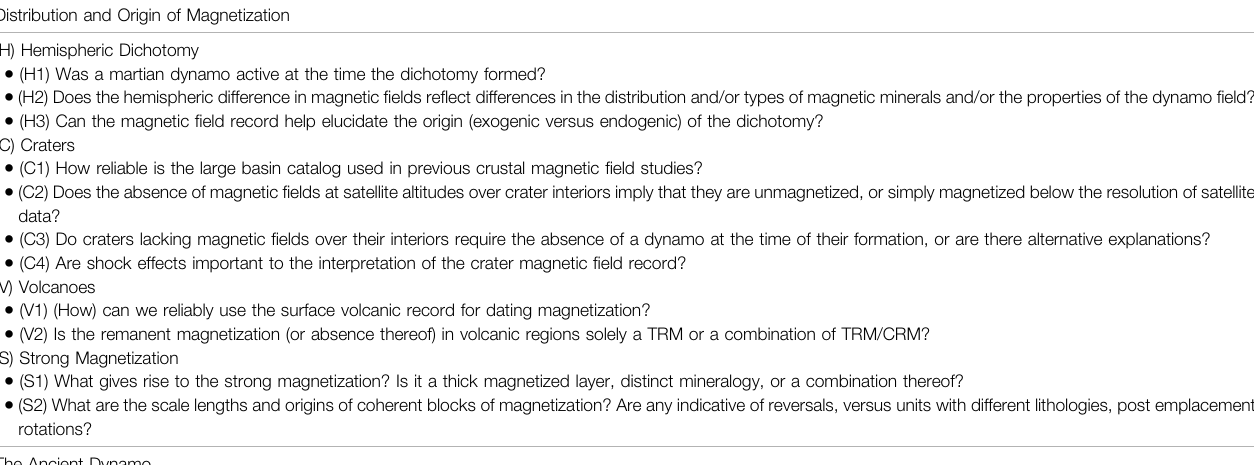
TABLE 1 | Summary of key questions magnetic fi eld data can